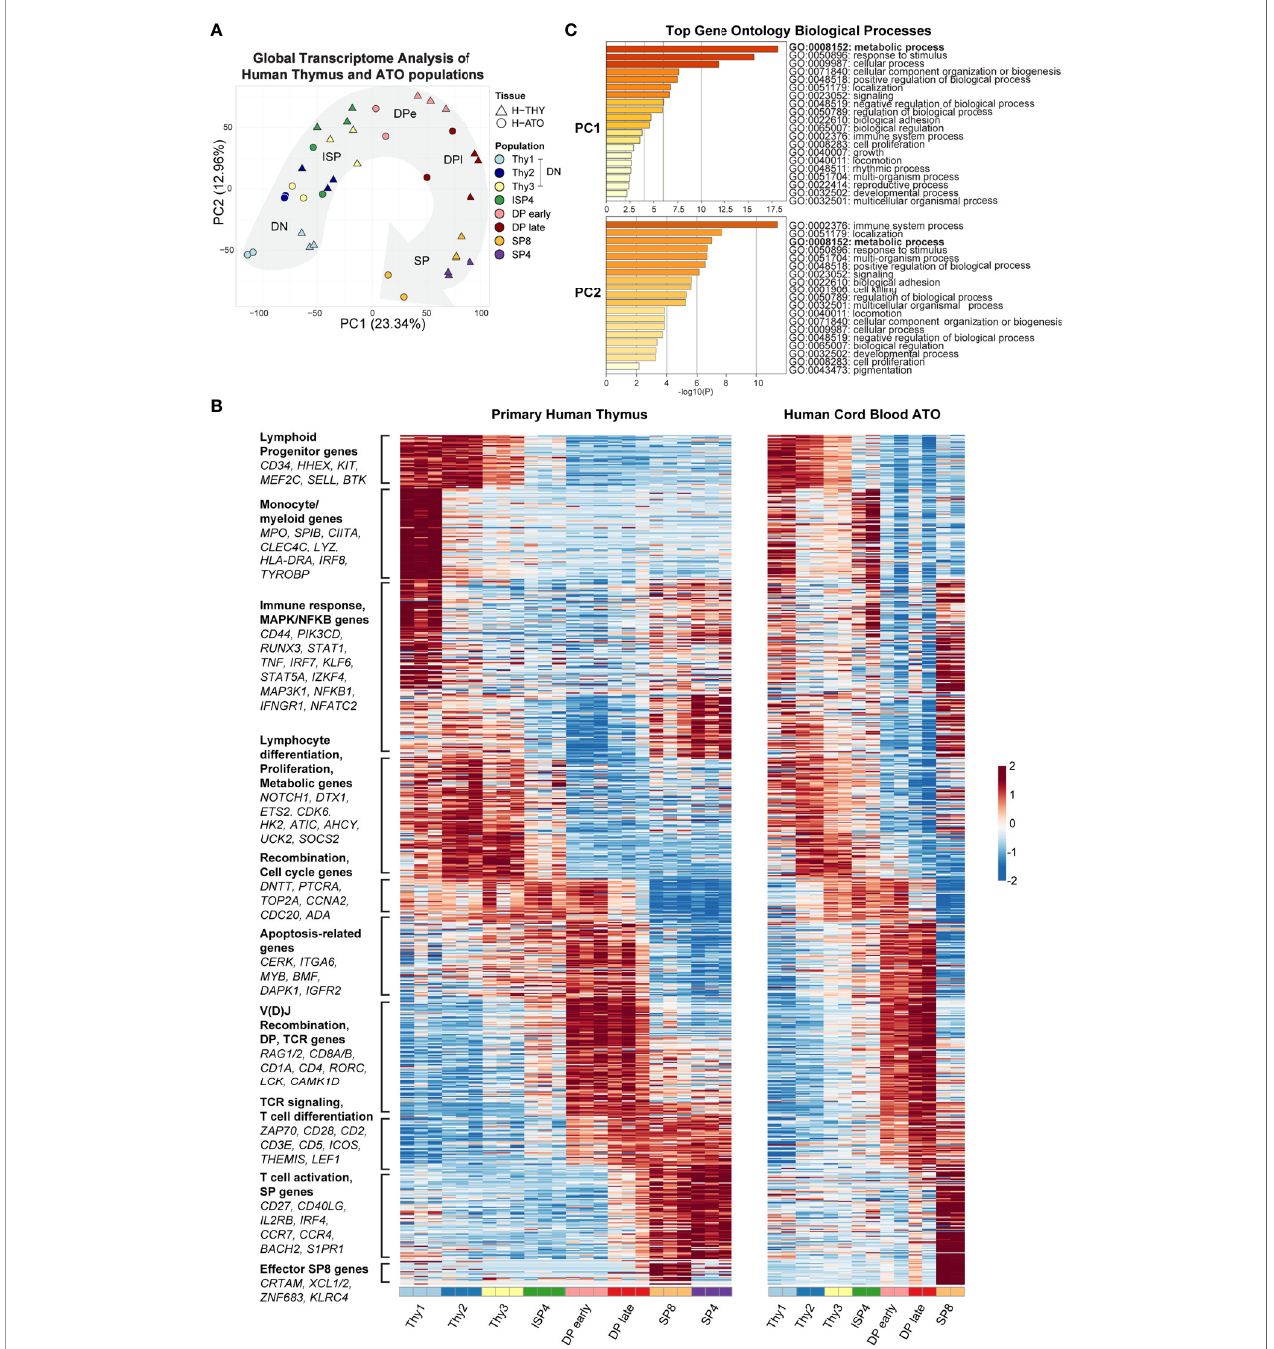
FIGURE 2 | (A) Principal-component analysis (PCA) of gene expression for human thymic and H-ATO-derived populations. PC1 and PC2 are shown along with the percentage of gene expression variance explained. Clustering was obtained with data from all detected genes without additional fi lters. Population phenotypes from each source are provided in Supplementary Table 1 . SP4 population was not collected from H-ATO. Background arrow shows direction of differentiation. (n=3 independent replicates for H-THY; n=2 for H-ATO) (B) Hierarchical model-based clustering of 769 highly variable genes classi fi ed as differentially expressed (Wald adjusted p value < 0.01, fold change > 4) within and between human thymic and ATO-derived populations. The x axis indicates populations isolated for analysis. Each heatmap represents z -scores of normalized variance-stabilized gene expression data. To summarize the unsupervised hierarchical clustering results, we highlight for each cluster an ontology annotation signi fi cantly associated with genes overrepresented in each cluster, along with manually selected genes known to be involved in T cell development. The full list of genes as ordered in the heatmap is provided in Supplementary Table 2 . (n=3 independent replicates for H-THY; n=2 for H-ATO). (C) Top GO terms signi fi cantly enriched in PC1 and